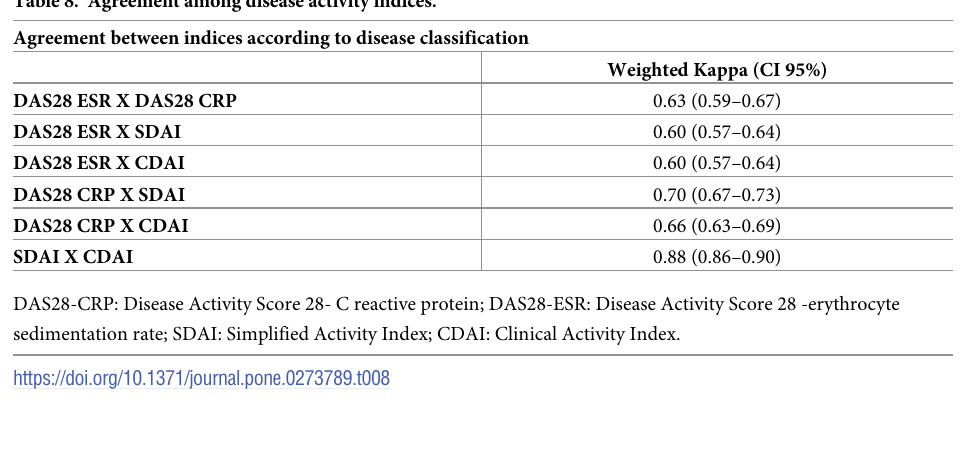
Table 8. Agreement among disease activity indices.